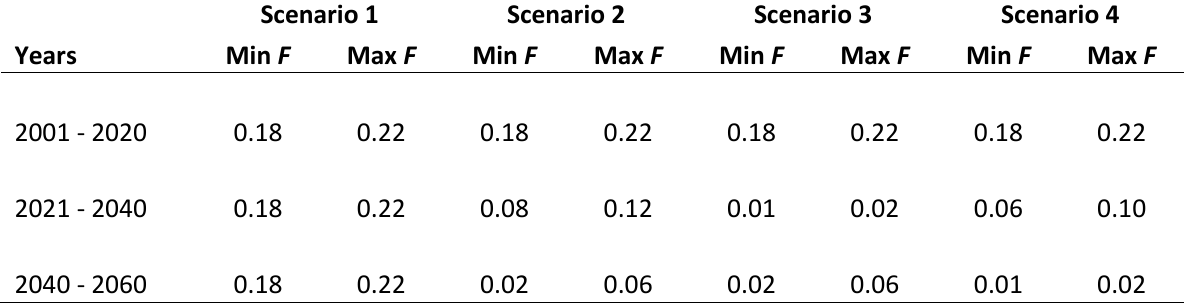
Table 42. Scenarios of F simulated by the operating model to generate data sets used in a surplus production model and a catch survey model. Fishing mortality varied annually according to a uniform distribution with bounds described